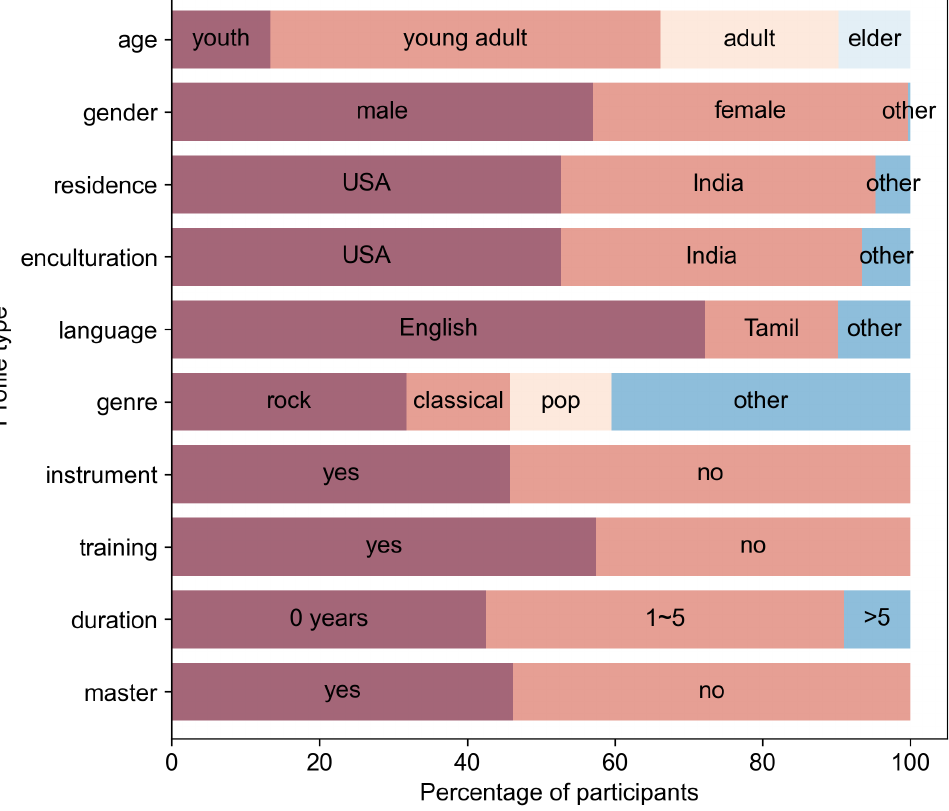
Figure 3. Proportion of participants for each of the profile features.